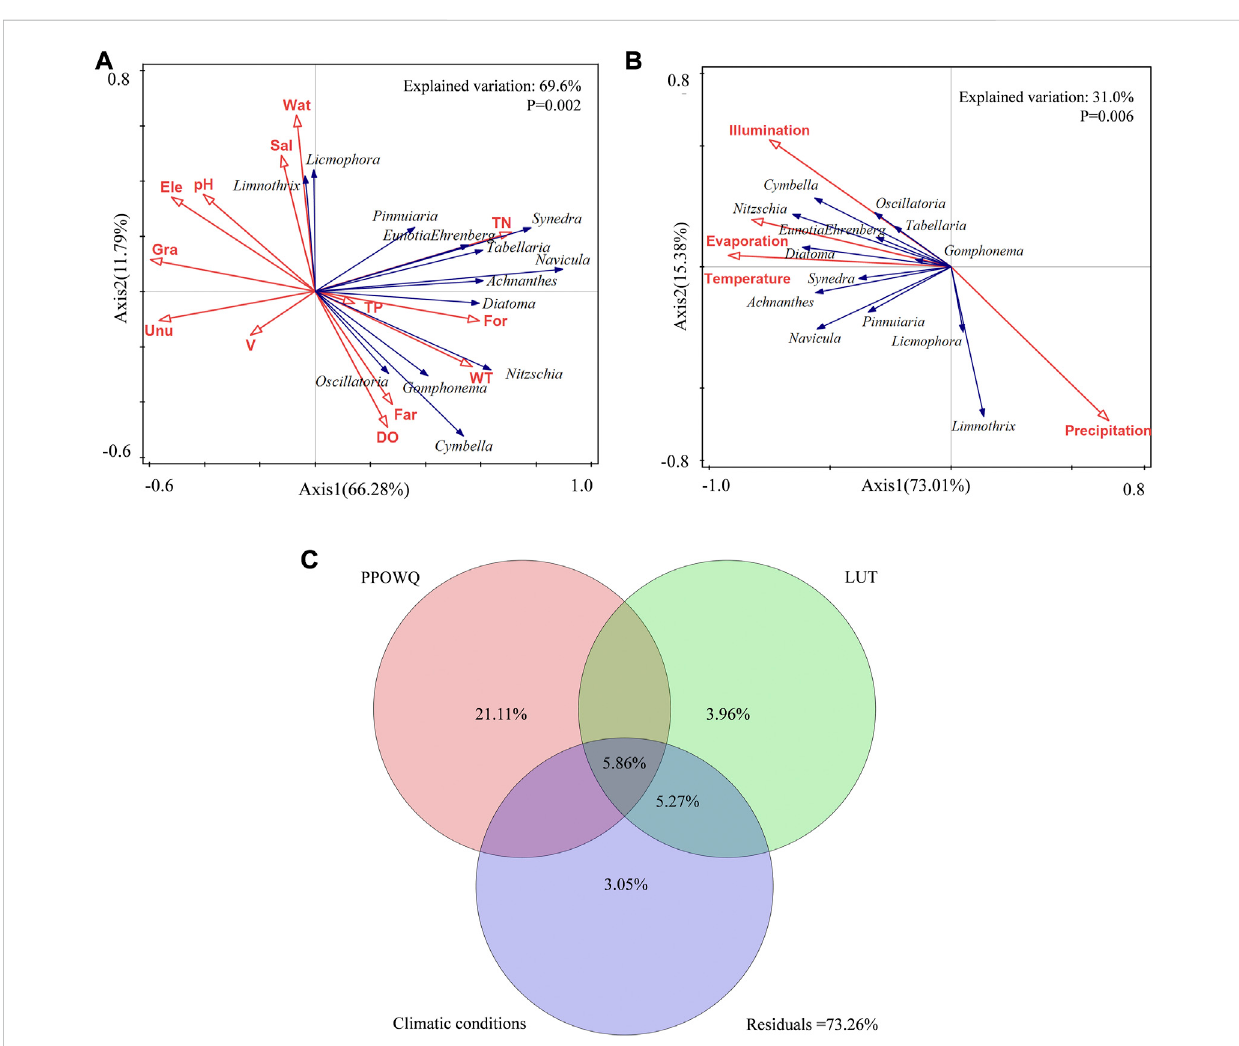
FIGURE 6 (A,B) Redundancy analysis of the effects of PPOWQ, LUT and climatic conditions on phytoplankton communities and (C) venn analysis showing the common effects of PPOWQ, LUT and climatic conditions on phytoplankton community.